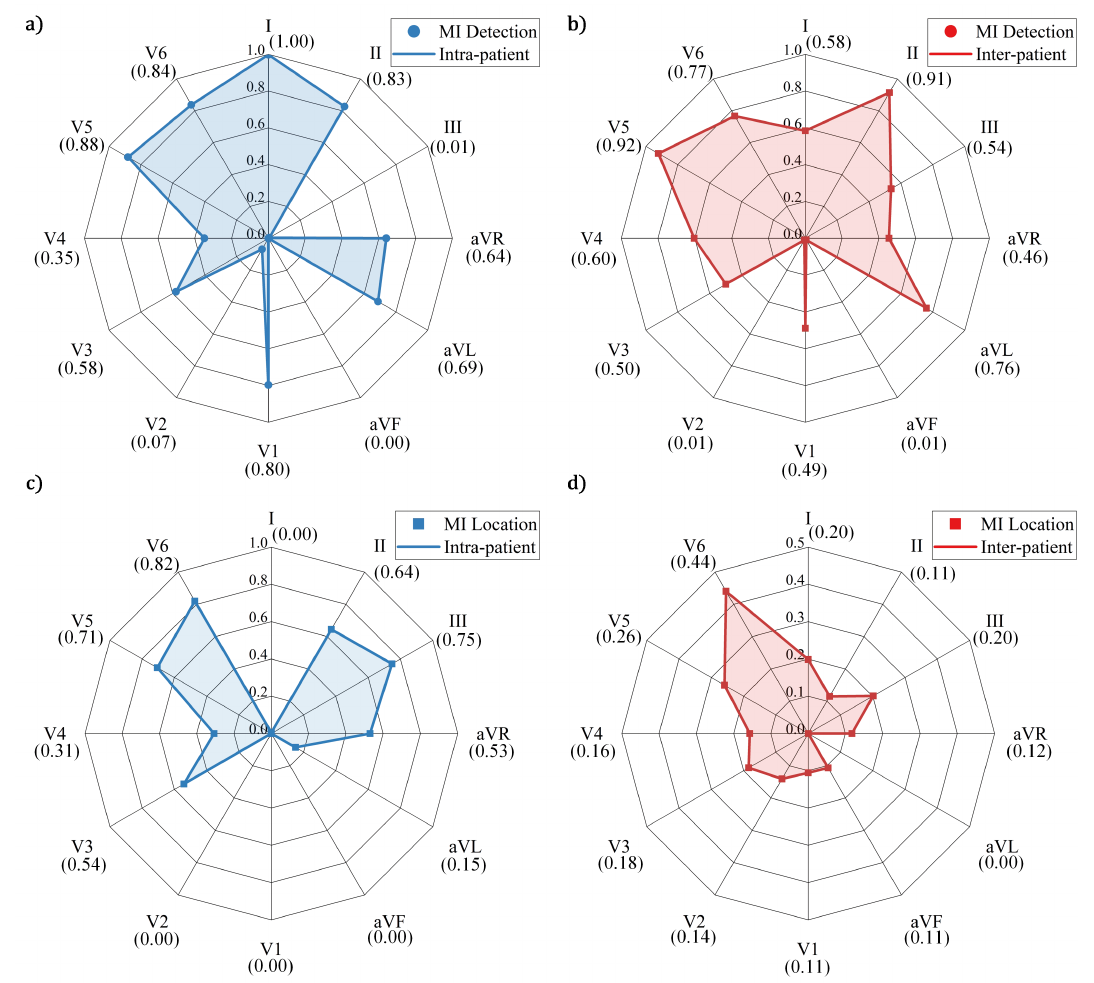
Figure 5. Lead weights obtained by five-fold cross-validation: ( a ) lead weights in MI detection under intra-scheme; ( b ) lead weights in MI detection under inter-scheme; ( c ) lead weights in MI location under intra-scheme; and ( d ) lead weights in MI location under